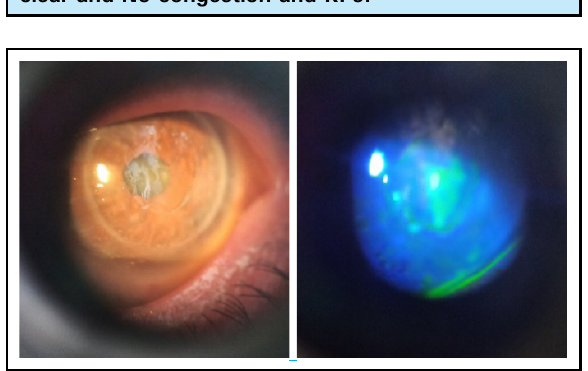
Figure 2. LE Post graft with irregular epithelium (A). Epithelial defect seen after Florescein stain (B).